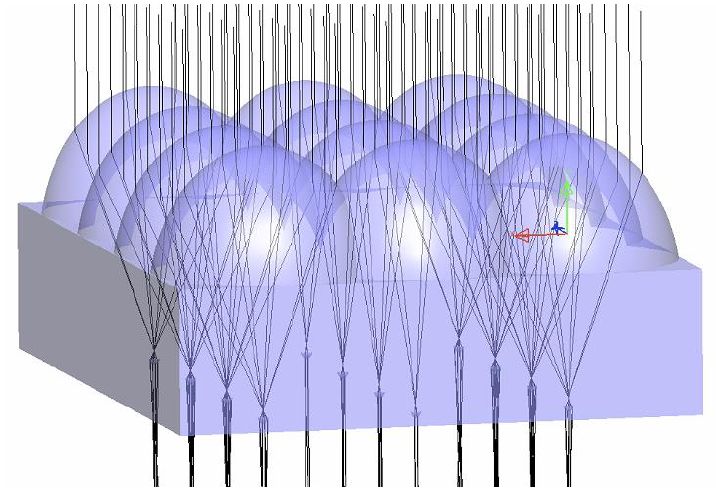
Figure 5. The structure of the primary concentrator consisting of dual-lens concentrator units and the ray-tracing simulation using LightTools TM software (Version 9.0, Synopsys, Inc., Mountain View, CA, USA), showing that a wide beam can be collected and focused into multiple narrow areas.